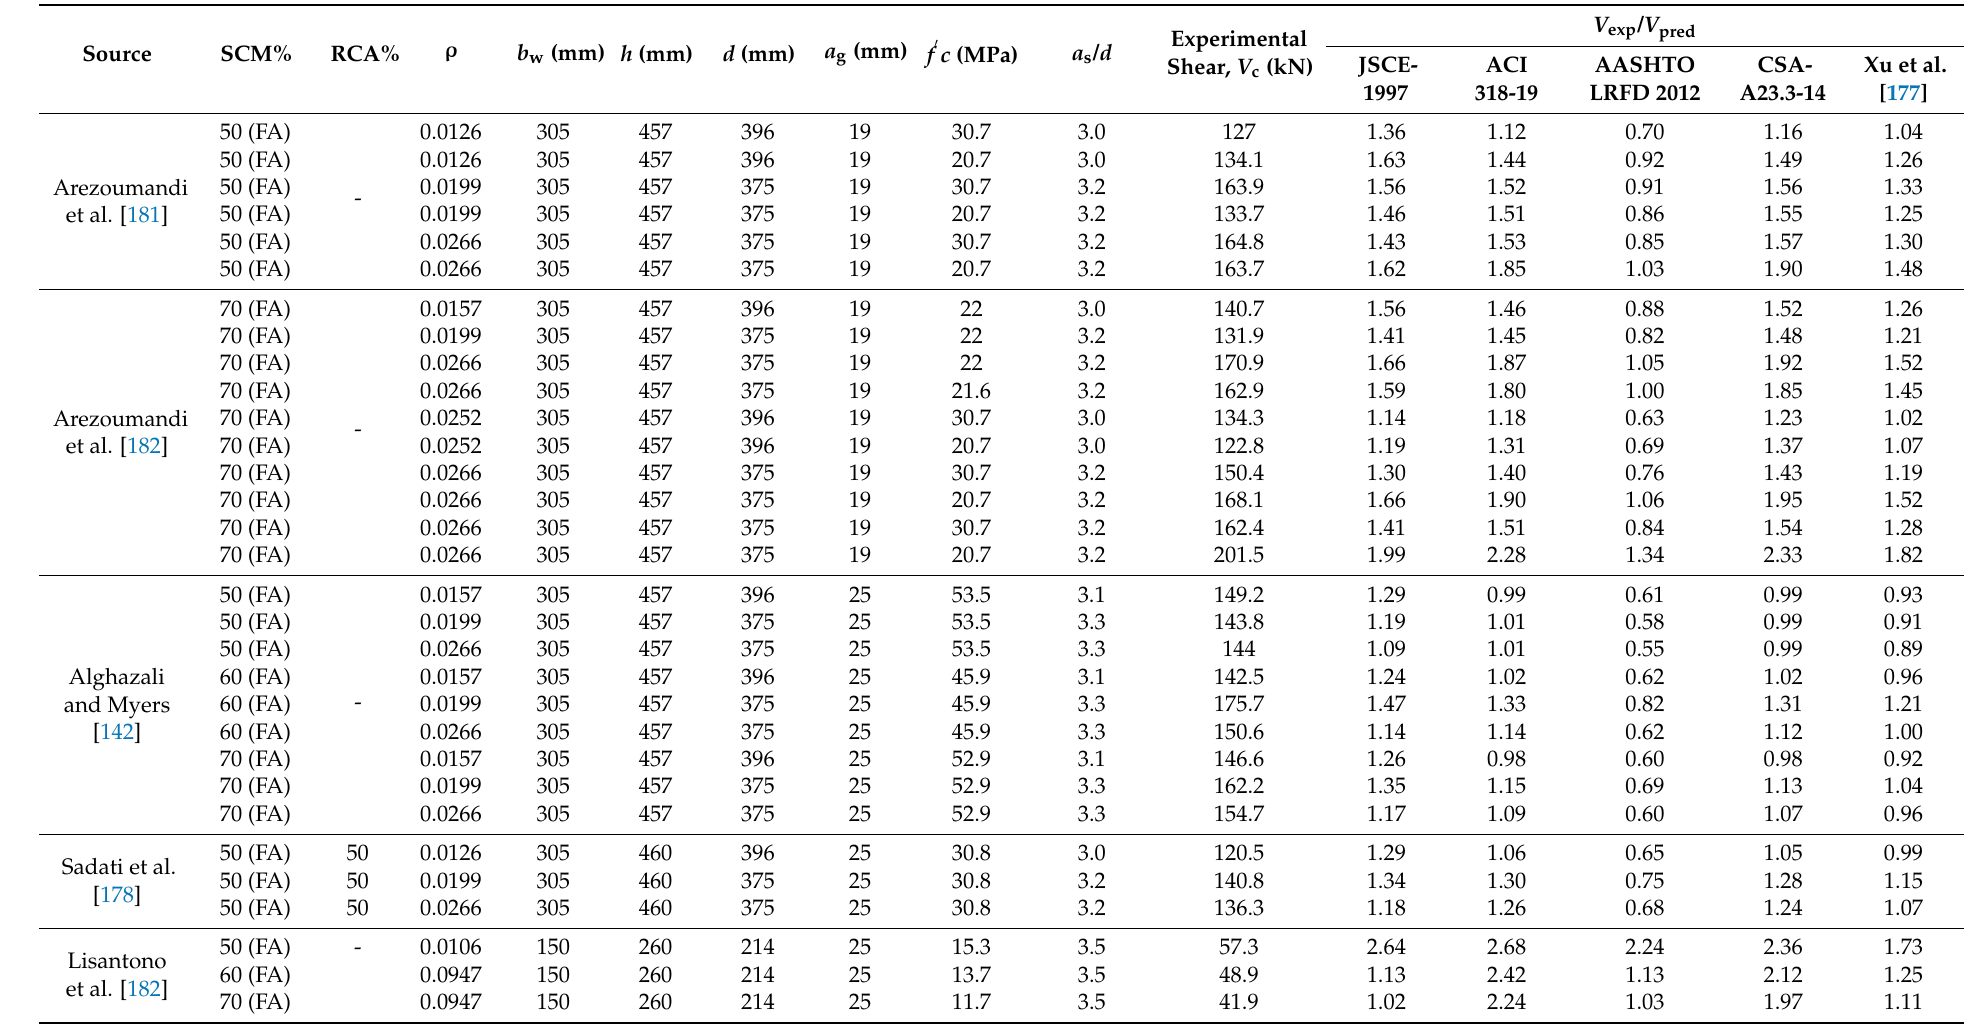
Table 2. Experimental and predicted shear capacities for reinforced concrete beams with partial